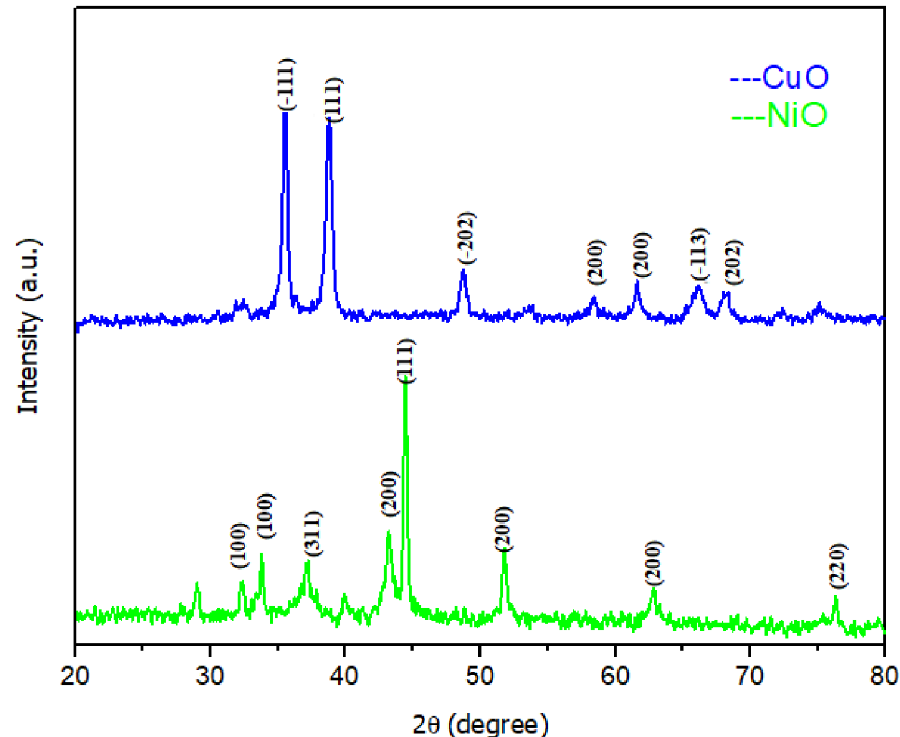
Figure 14. XRD pattern of CuO NPs and NiO NPs [168].